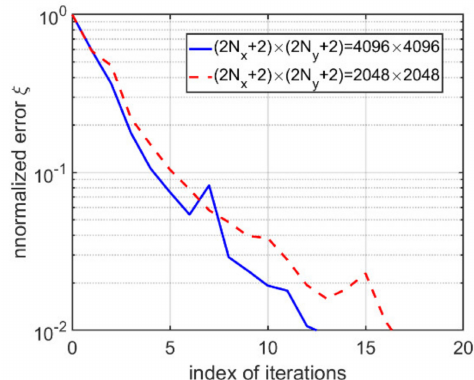
Figure 6. Normalized error ξ with respect to the index of iterations to reach the threshold ξ th = 0.01. Results are shown for two equi-spaced mesh: mesh with (2 N x + 2) × (2 N y + 2) = 4096 × 4096 and mesh with (2 N x + 2) × (2 N y + 2) = 2048 × 2048. Figure 7 shows numerical radiation patterns in